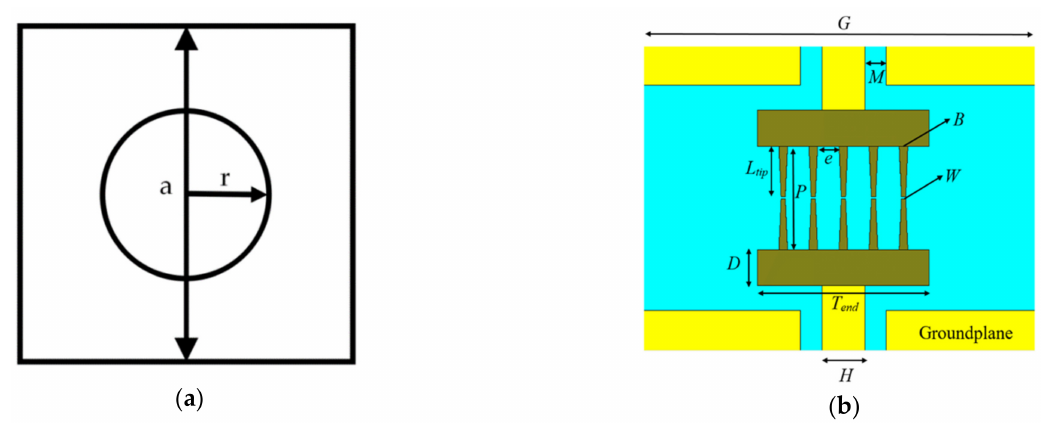
Figure 3. ( a ) Configurations of the 2D-PhC unit cell; ( b ) Top view of the photomixer based